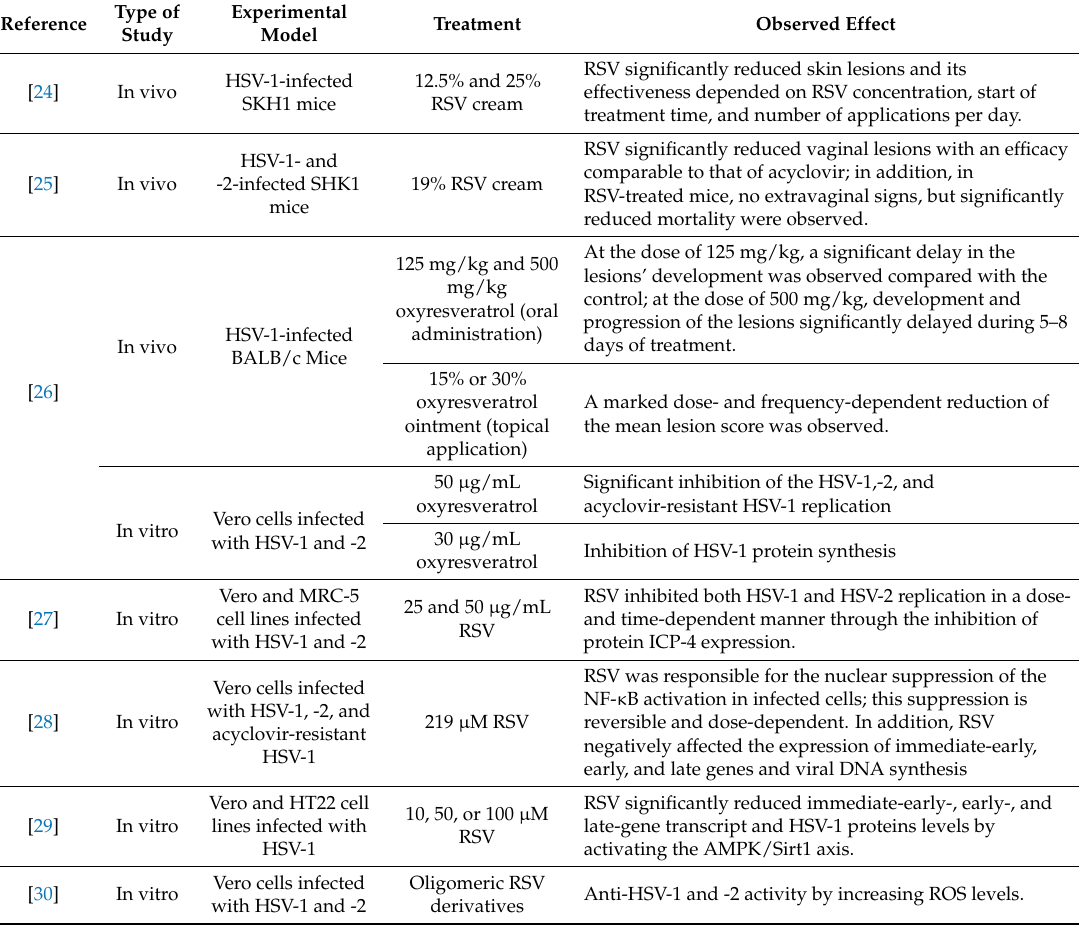
Table 1. In vivo and in vitro evidences demonstrating the anti-HSV activity of RSV and its derivatives.